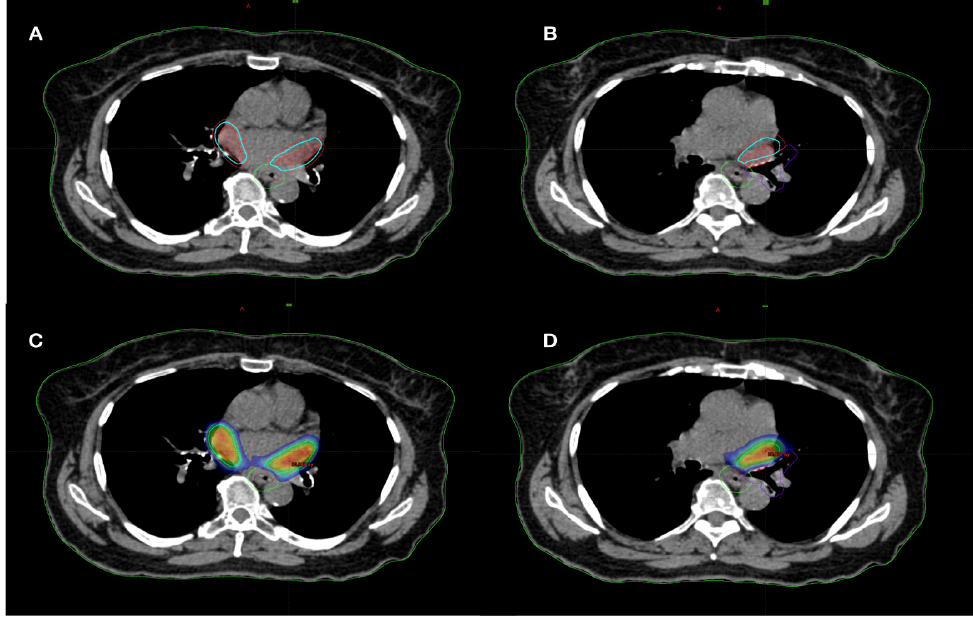
Figure 2. ( A , B ) PTV and ITV cropped from OaRs (esophagus and bronchus); ( C , D ) STAR Planning with simultaneous integrated protection dose. with simultaneous integrated protection